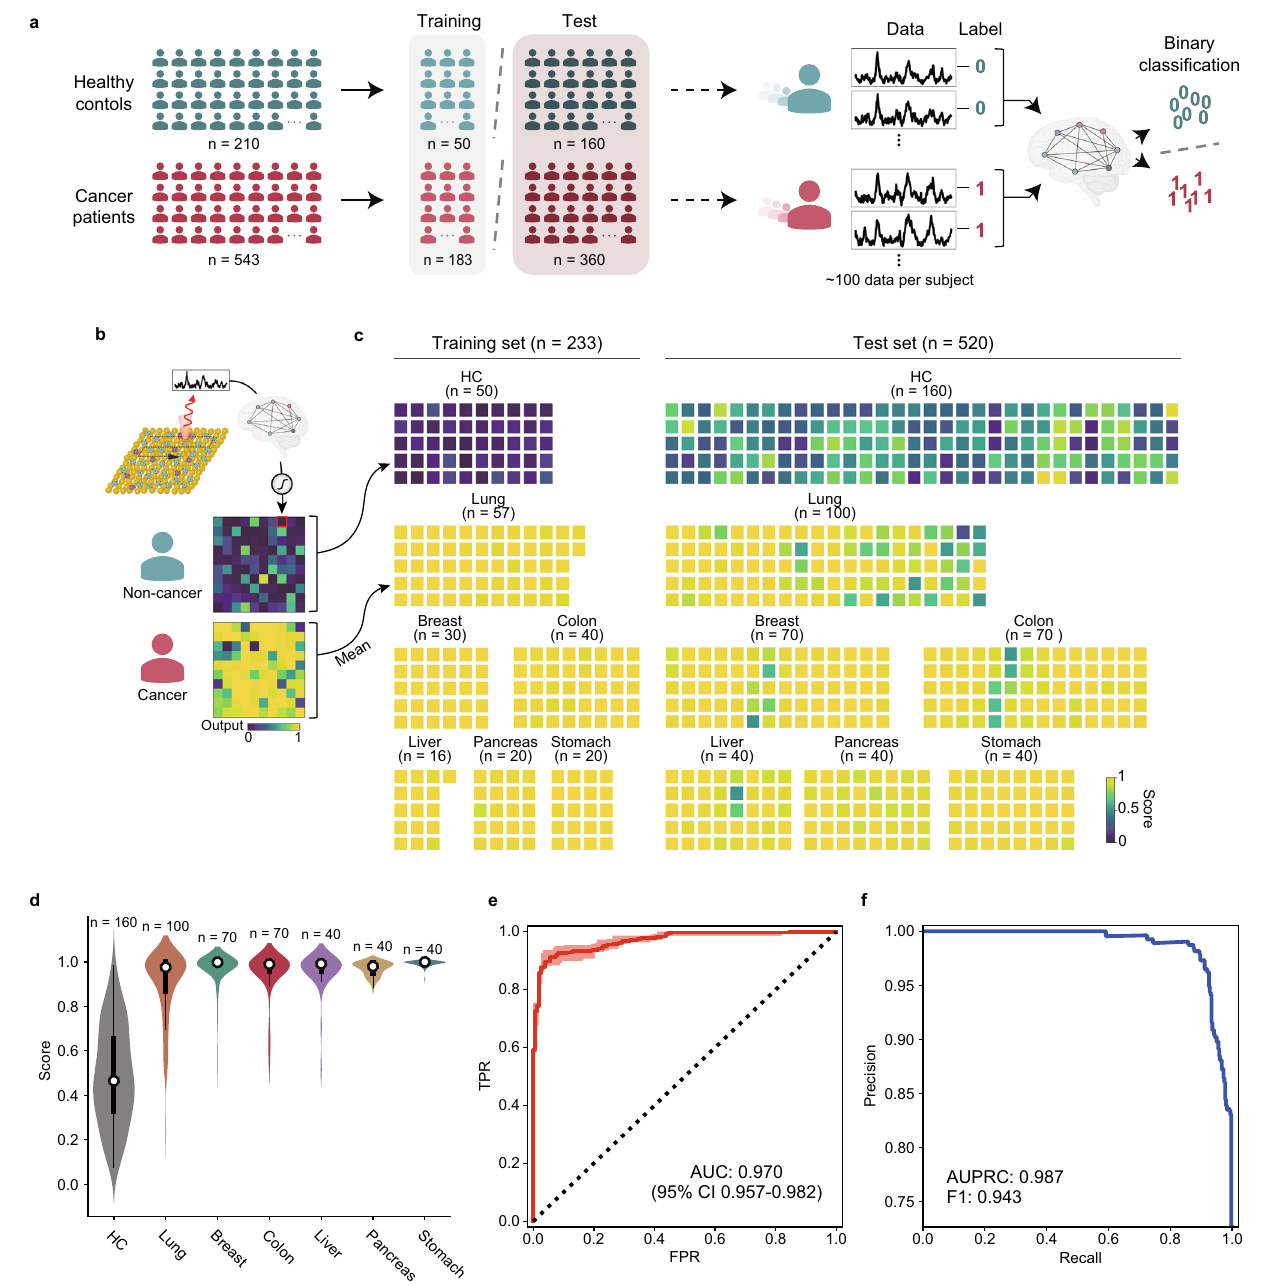
Fig. 3 | Cancer presence detection. a Training of the CNN classi fi er. Control and cancer patient samples were split into training ( n =200) and test ( n =289) sets. All datawerecomprehensivelylabeled bysampletype.TheCNNmodelwastrainedto produce a binary score of 0 or 1 using a sigmoid activation function. b Calculation of diagnostic scores. Model outputs corresponding to individual SERS signals are shownasaheatmap.Outputmeansareusedas fi naldiagnosticscores. c Diagnostic